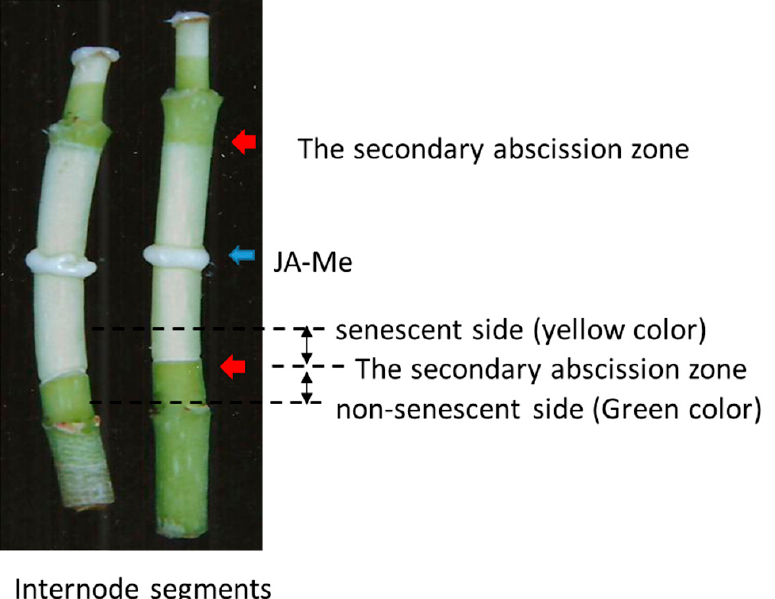
Figure 1. Secondary abscission zone (SAZ) induced by the application of methyl jasmonate (JA-Me) in internode segments of Bryophyllum calycinum . The treatment was made in the middle of internode explants. Photograph was taken 8 days after treatment. Red and blue arrows indicate the SAZ and JA-Me treatment place, respectively. Stem pieces (ca. 3–4 mm in length) above and below the SAZ were subjected to comprehensive plant hormone analyses.